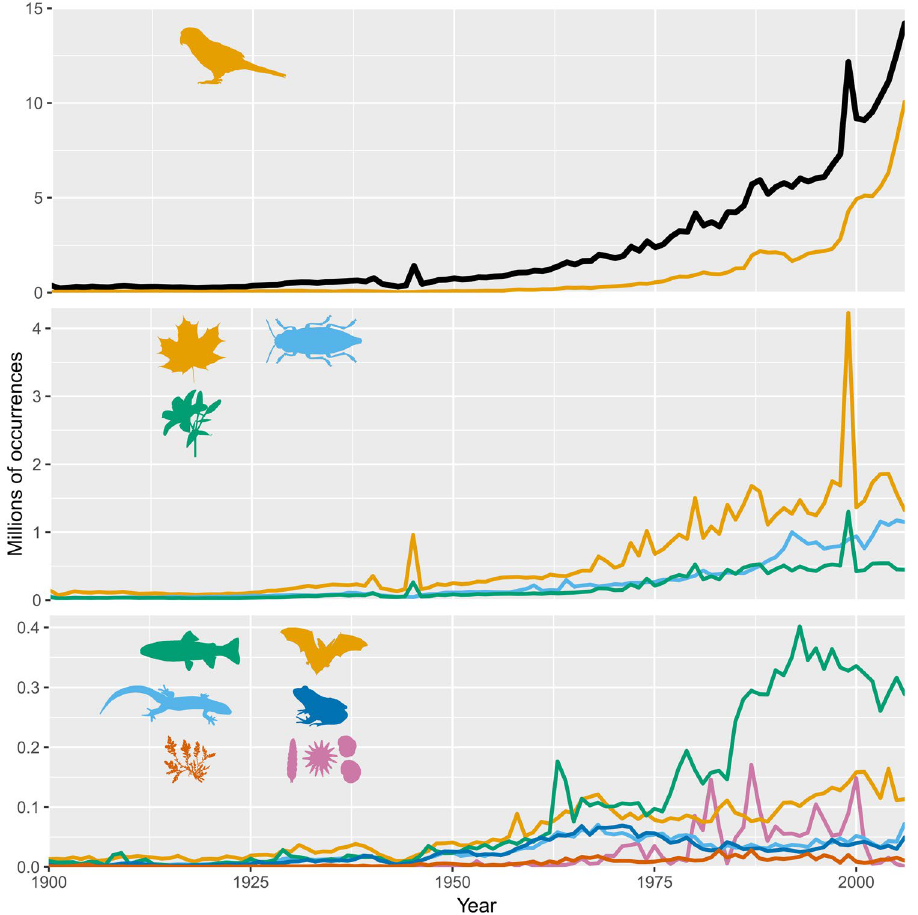
Figure 3. Biodiversity occurrences recorded in GBIF between 1900 and 2006. For each curve, the number of occurrences was plotted yearly. Top : black = all 24 classes considered together, yellow = Aves; Middle : yellow = Magnoliopsida, blue = Insecta, green = Liliopsida; Bottom : green = Actinopterygii, yellow = Mammalia, light blue = Reptilia, dark blue = Amphibia, orange = Florideophyceae, purple =